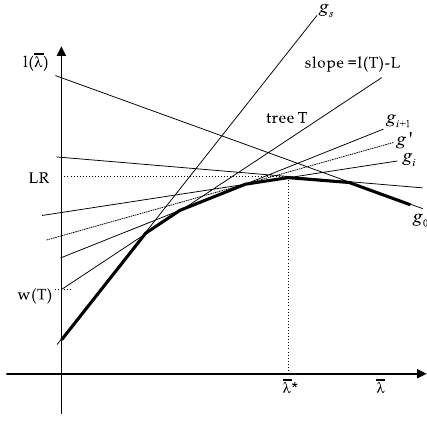
Fig. 1 Function l ( 𝜆 ) in space ( l , 𝜆